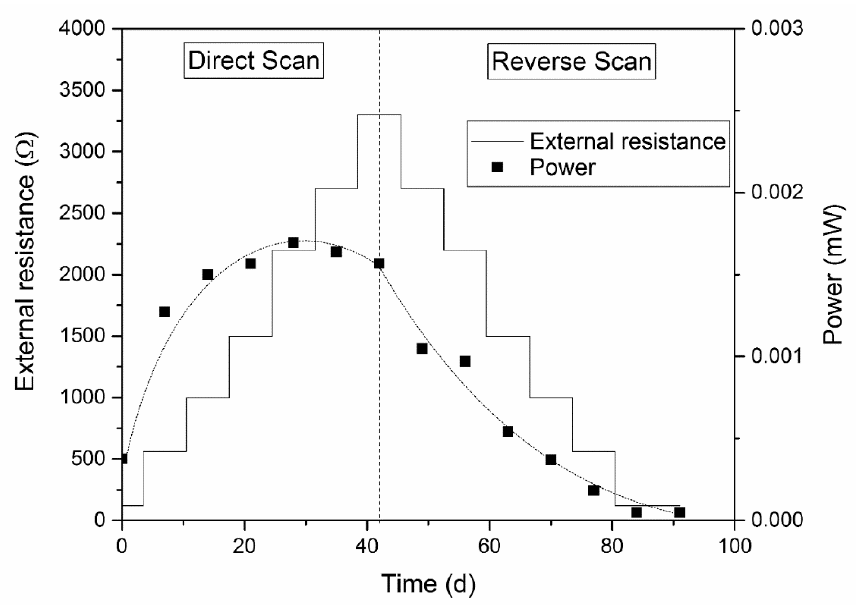
Figure 3. The power exerted by the MFCs at every external resistance.